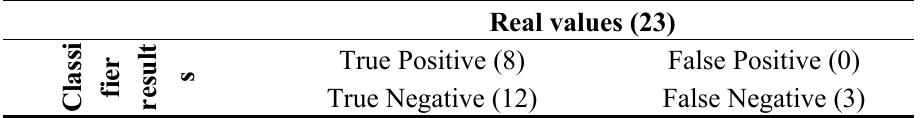
Table 1. Binary classifier defined by a 2 × 2 matrix with the obtained results in the